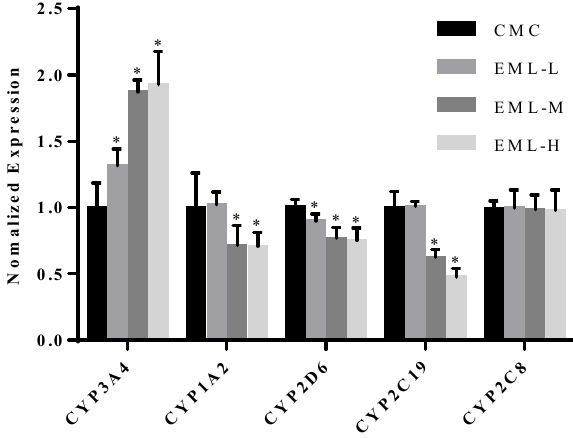
FIGURE 8 – Effect of EML on mRNA expression of CYP3A1, CYP1A2, CYP2D2, CYP2C11 and CYP2C7 in rats (n = 6). *P < 0.05 versus control